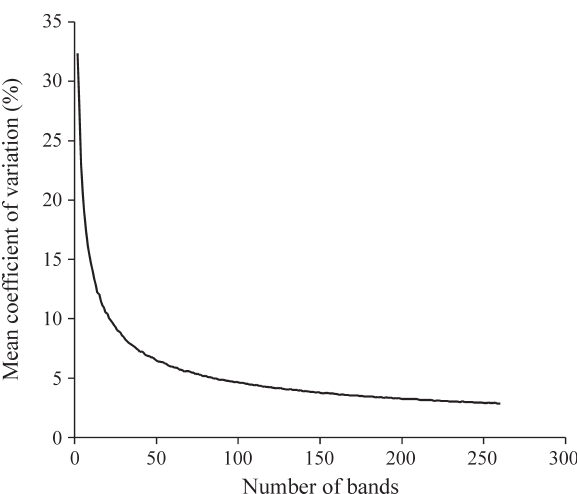
Figure 3 - Sample variance of genetic similarity estimation for 81 maize accessions as depicted by the relationship between the mean coefficient of variation (%) and number of bands derived from a bootstrap